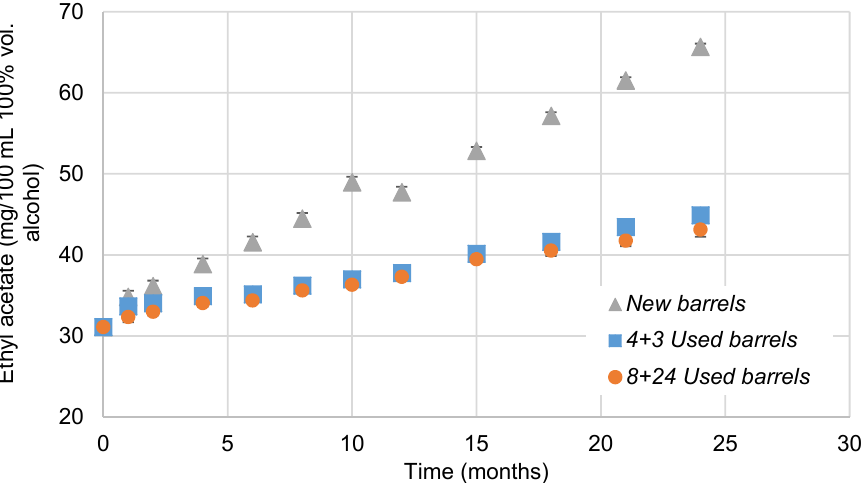
Figure 4. Evolution of ethyl acetate in brandies aged in New barrels , 4 + 3 Used barrels and 8 + 24 Used barrels for two years, expressed in mg/100 mL of 100% vol. alcohol. When the standard deviation was lower than 0.9 cannot be noticed in the graph.